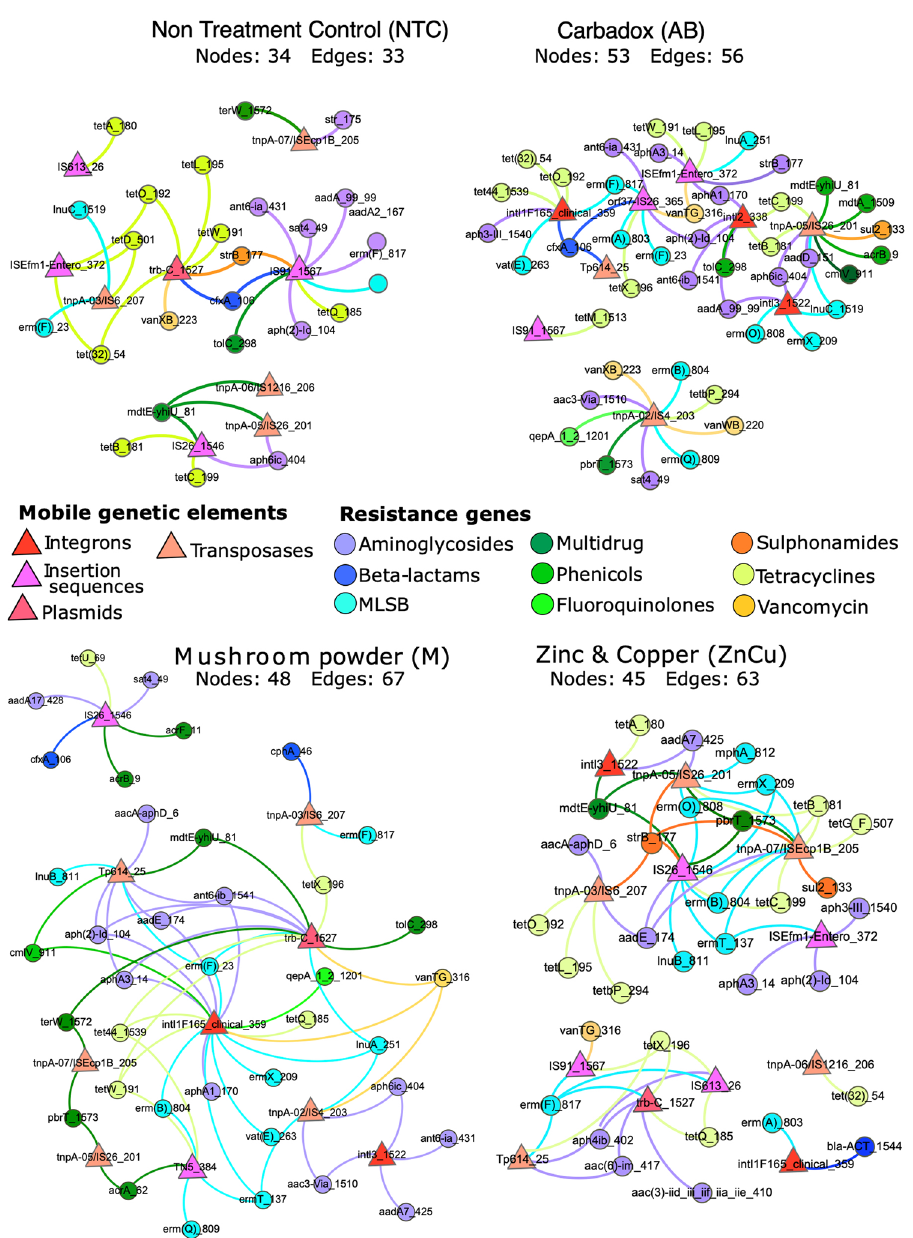
Figure 4. Network analysis showing co-occurrence patterns between ARGs and MGEs within the samples in different treatment groups. Nodes of the MGEs are triangles, and circle resistance gene nodes are colored according to the antibiotic they confer resistance. Edges between resistance gene nodes and mobile genetic element nodes have the color of the resistance gene node. Nodes have equal sizes, edges have equal weights, and distance between the nodes is irrelevant. Numbers of nodes and edges were higher in the growth promoter groups (AB, M and ZnCu) than in the control group network (NTC), suggesting increased ARG mobility potential in response to growth